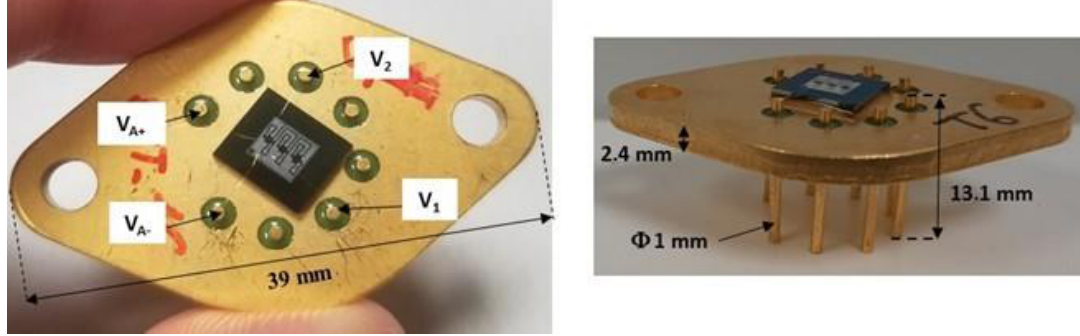
Figure 12. Photographs of the transducer die on its TO3 stainless steel holder.